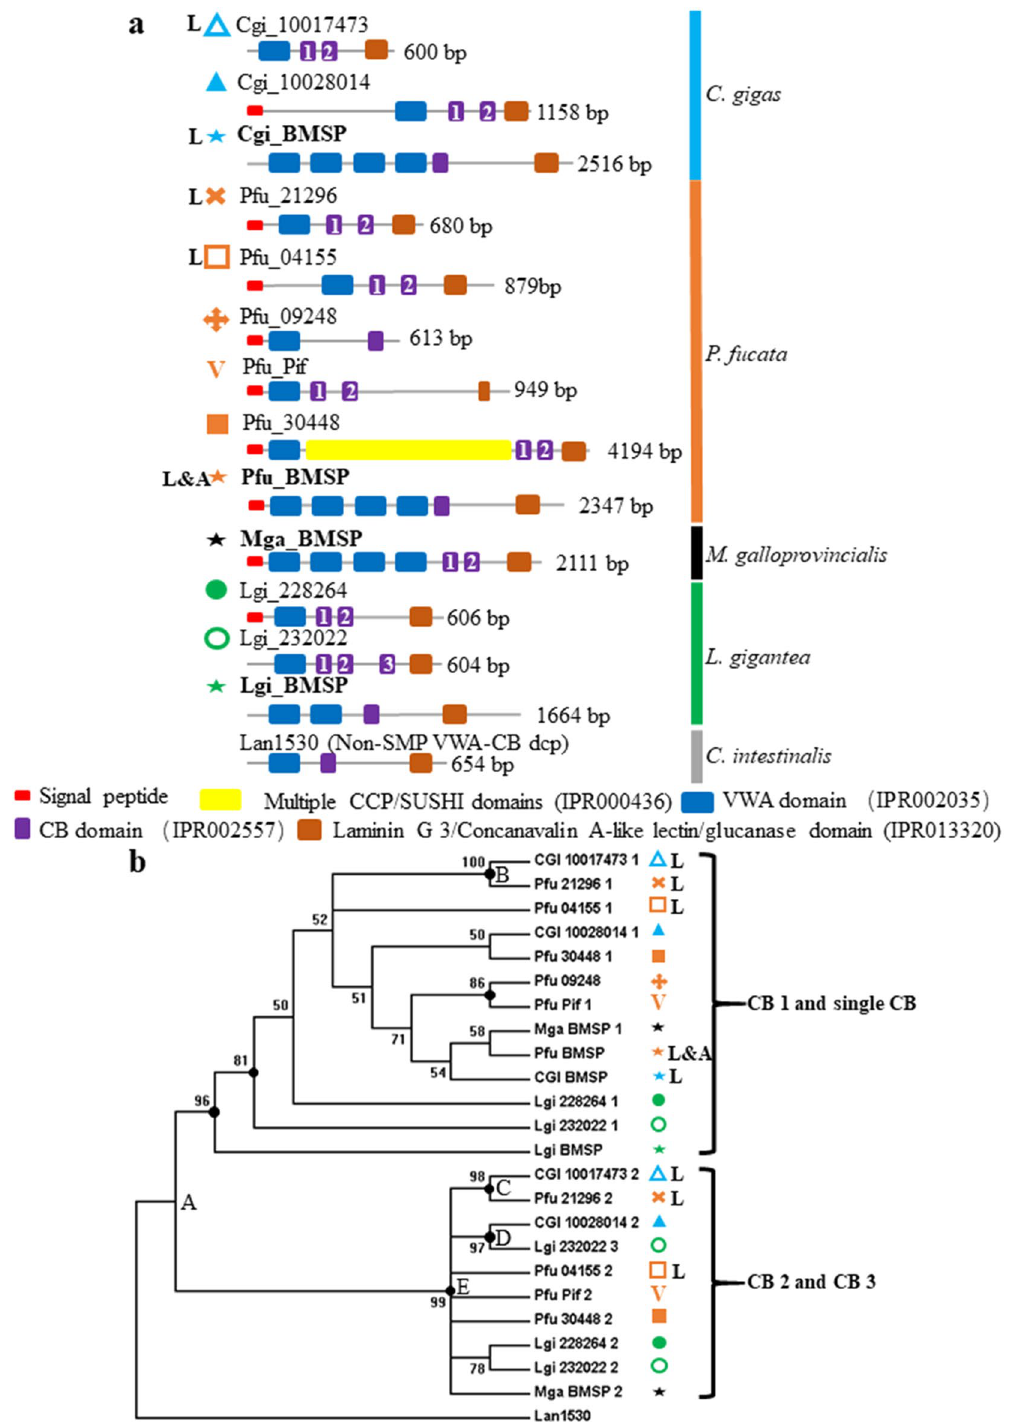
Figure 1. Phylogenetic analyses of CB domains of VWA-CB dcps of molluscan shells. ( a ) Schematic representations of the domain structures of shell-specific VWA-CB dcps. ( b ) A Bayesian tree based on LG model and 84 amino acid residues. Polychotomy is generated if the posterior probability value of the node is < 50. Posterior probability values are shown if ≥ 50, and marked with black dots if ≥ 80. The same symbols denoting different proteins in panel a are used in panel b. Larval SMPs are marked by “L”, and Pfu-BMSP identified in both larval and adult shells of P. fucata is marked by “L&A”. Cgi, Crassostrea gigas ; Pfu, Pinctada fucata ; Mga, Mytilus galloprovincialis ; Lgi, Lottia gigantea ; Lan, Lingula anatina